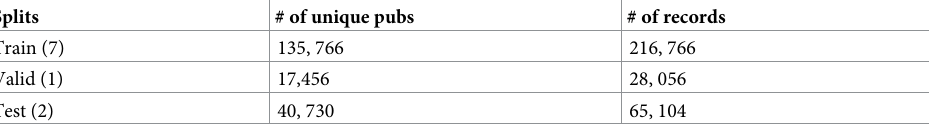
Table 3. Train, validation and test data.